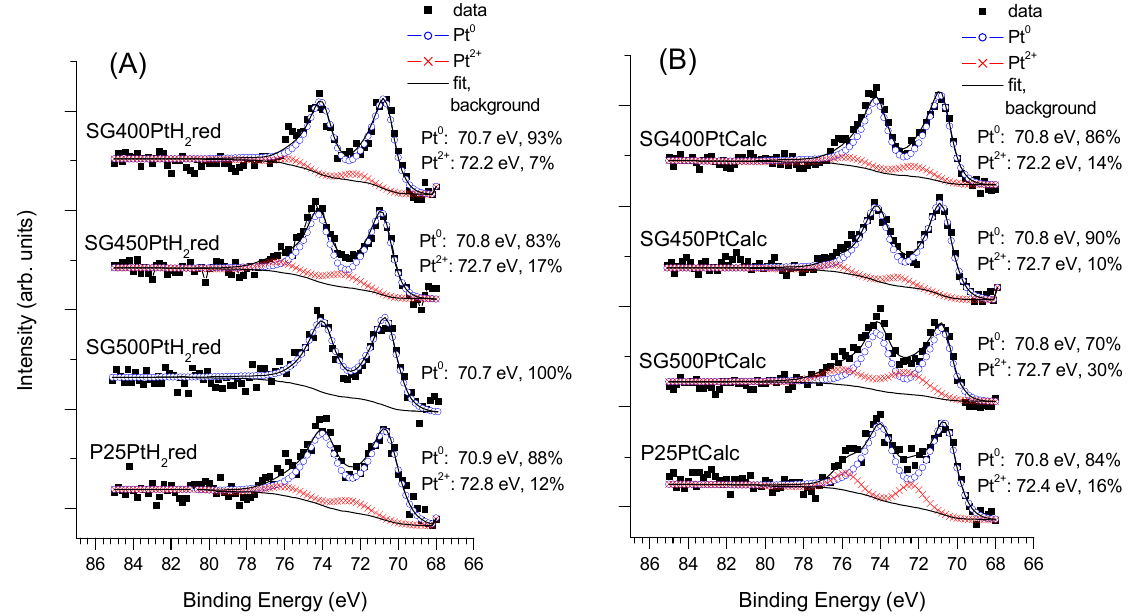
Figure 9. Pt 4f spectra of the recovered Pt-PtO x /TiO 2 photocatalysts activated by ( A ) H 2 reduction, ( B ): calcination. All spectra were collected after cca. 1 h X-ray exposure.